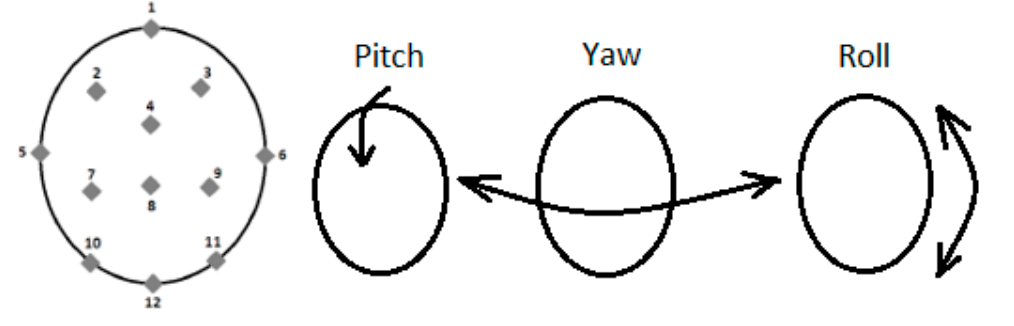
Figure 4. Tracked features for head position and movement.